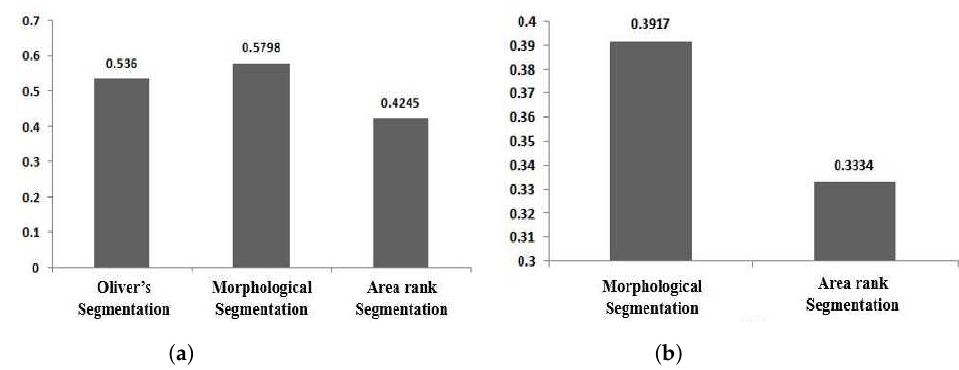
Figure 9. ( a ) Dice similarity score to compare segmentation results of Oliver’s segmentation method, and our proposed two segmentation methods using the DDSM database; and ( b ) Dice similarity score to compare segmentation results of our proposed two segmentation methods using the MIAS